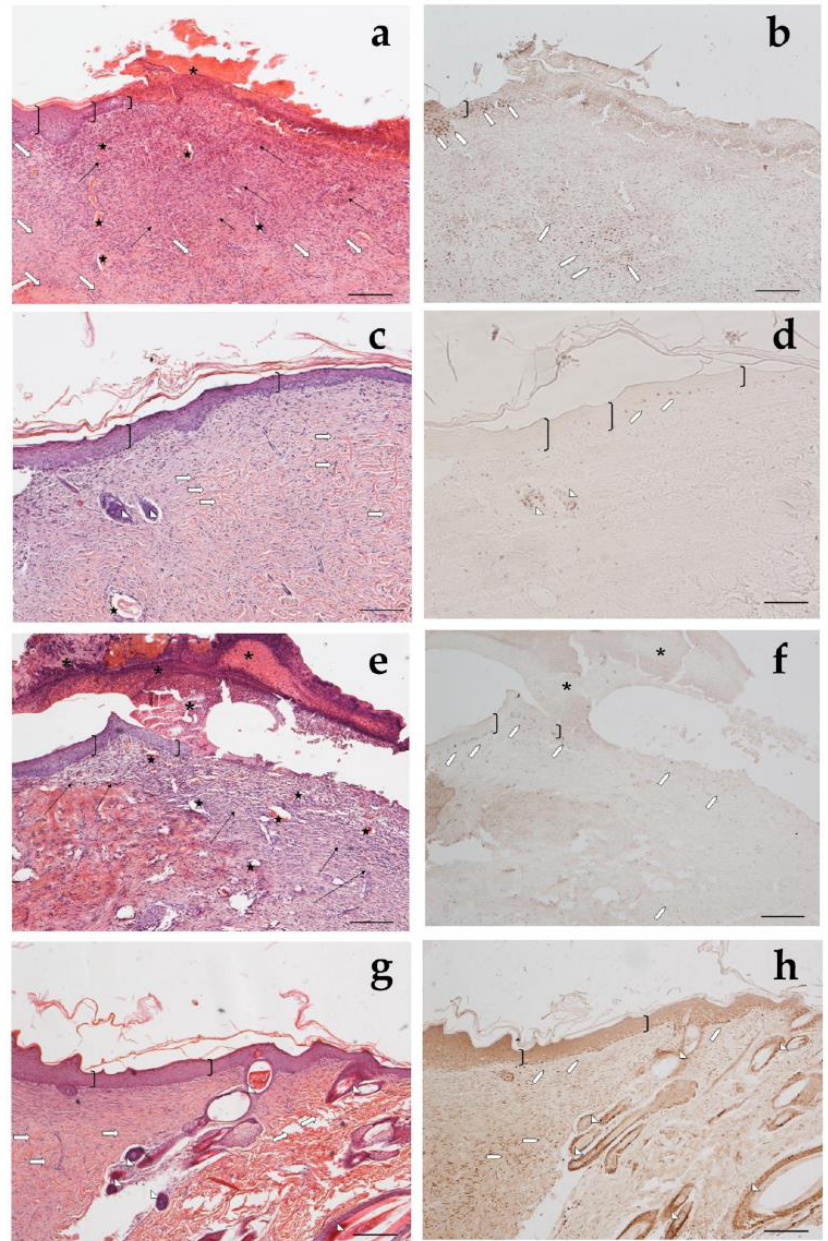
Figure 12. Haematoxylin and eosin staining ( a , c , e , g ) and BrdU sections ( b , d , f , h ) of skin specimens. Light microphotographs (5 × ) of skin sections 18 days after treatment with CSO–CO 50 ( a , b ), CSO–CO 100 ( c , d ), or saline solution (NaCl, 0.9% w / v ) ( e , f ). Light microphotograph (5 × ) of intact tissue is illustrated in panel ( g , h ). Skin structures are labeled as follows: epidermis = bracket; vessel = star; inflammatory infiltrate = black arrows; hair follicle = triangle; organized collagen bundles = white arrow; necrotic material = asterisk; BrdU-labelled nuclei = white pentagon. Scale bar = 200 µ